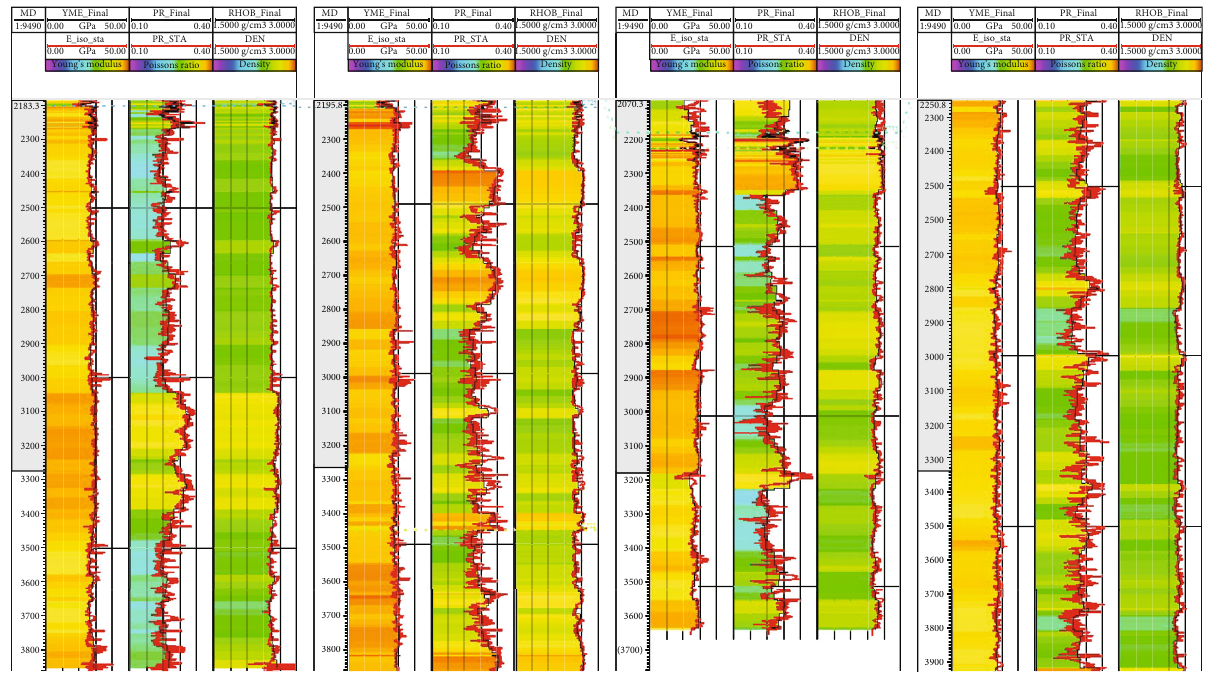
Figure 8: Comparisons of 1D (red line) and 3D (colored) mechanical properties in this study.